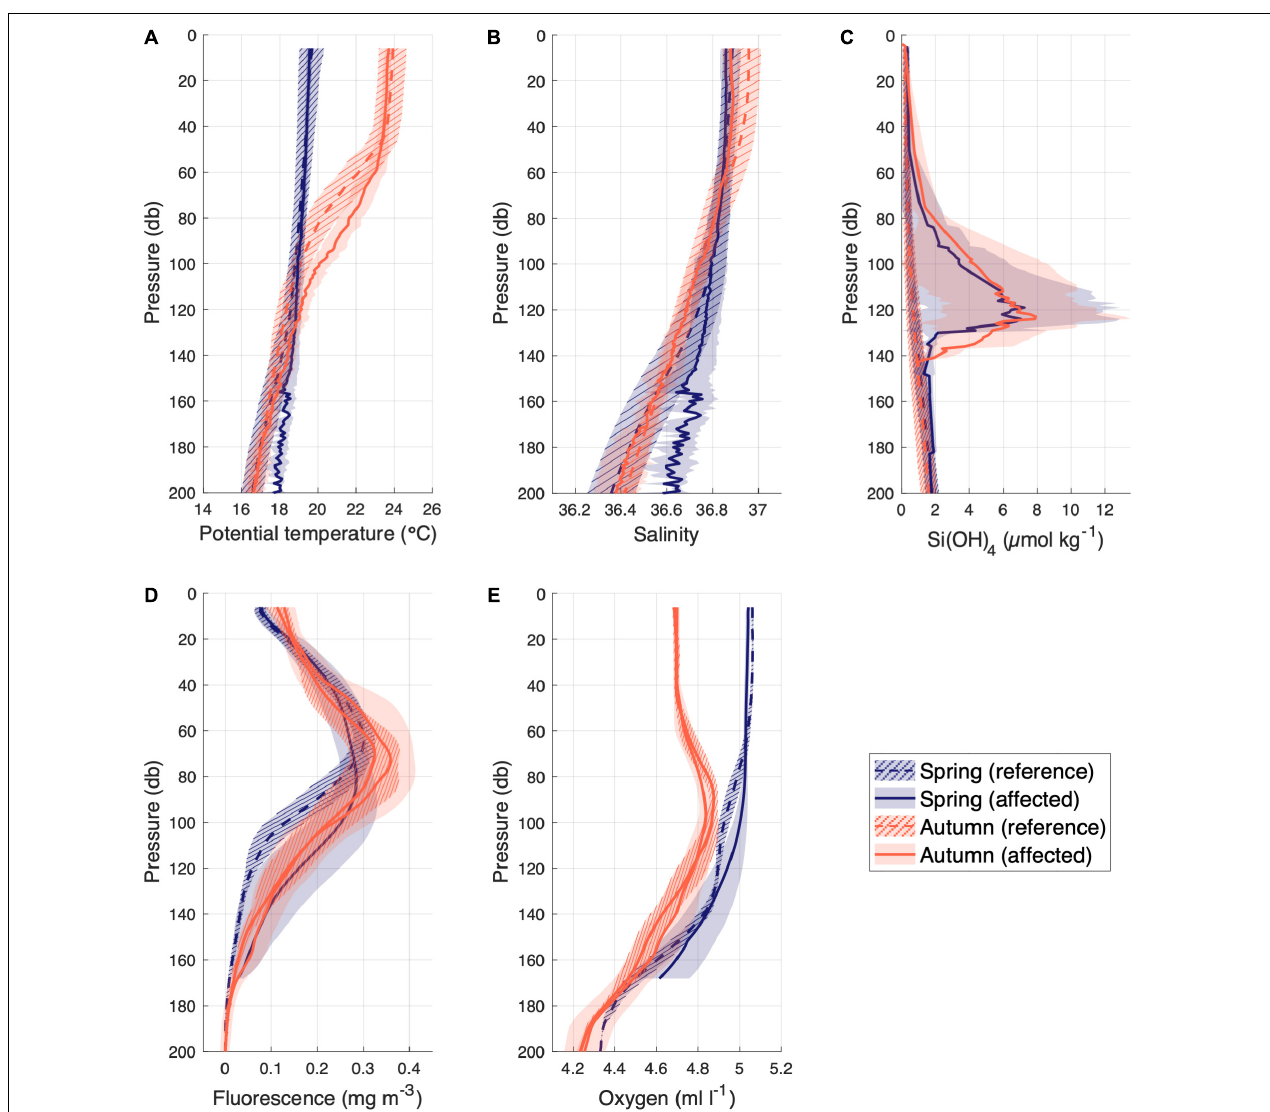
FIGURE 2 | Average vertical profiles of (A) Potential temperature ( ◦ C) (B) Salinity (C) Si(OH) 4 ( µ mol kg − 1 ) (D) Fluorescence (mg m − 3 ) and (E) Dissolved Oxygen (ml l − 1 ) concentration in the upper 200 m depth of the affected stations (solid line) and unaffected stations (dashed lines) by the volcano in spring (blue) and autumn (orange). The shaded areas around each line represent the standard